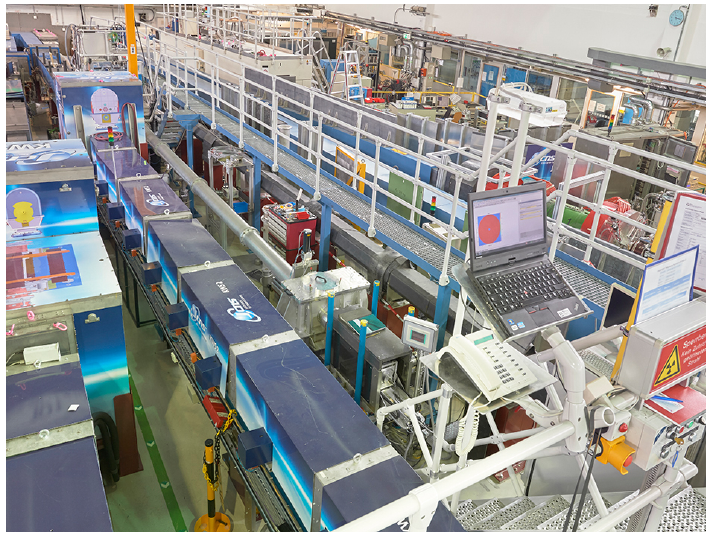
Figure 1: Instrument KWS-3 (Copyright by W. Schürmann,